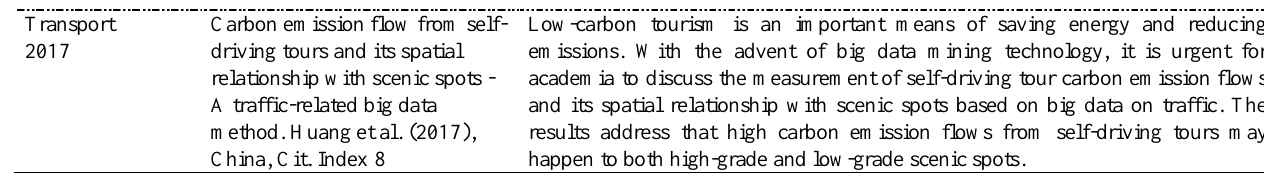
Table 2. Main categories, article information, and main description of the selected